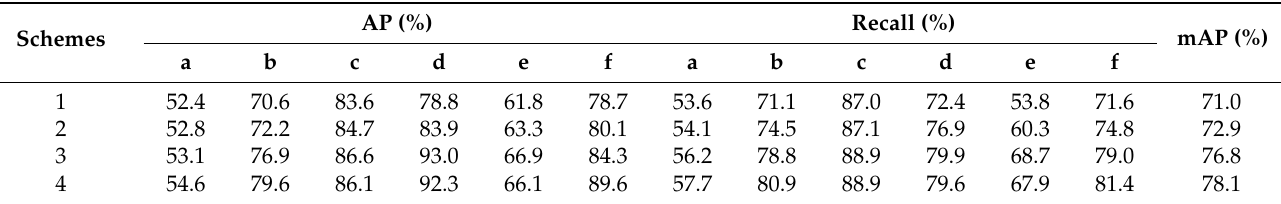
Table 6. The comparison results of four